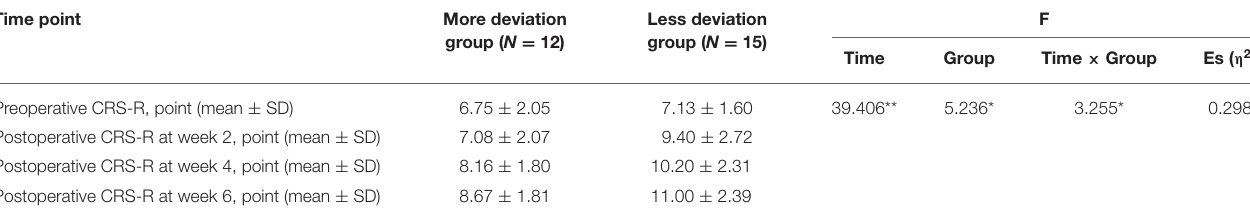
TABLE 4 | The effect of EDA on treatment effect over time.